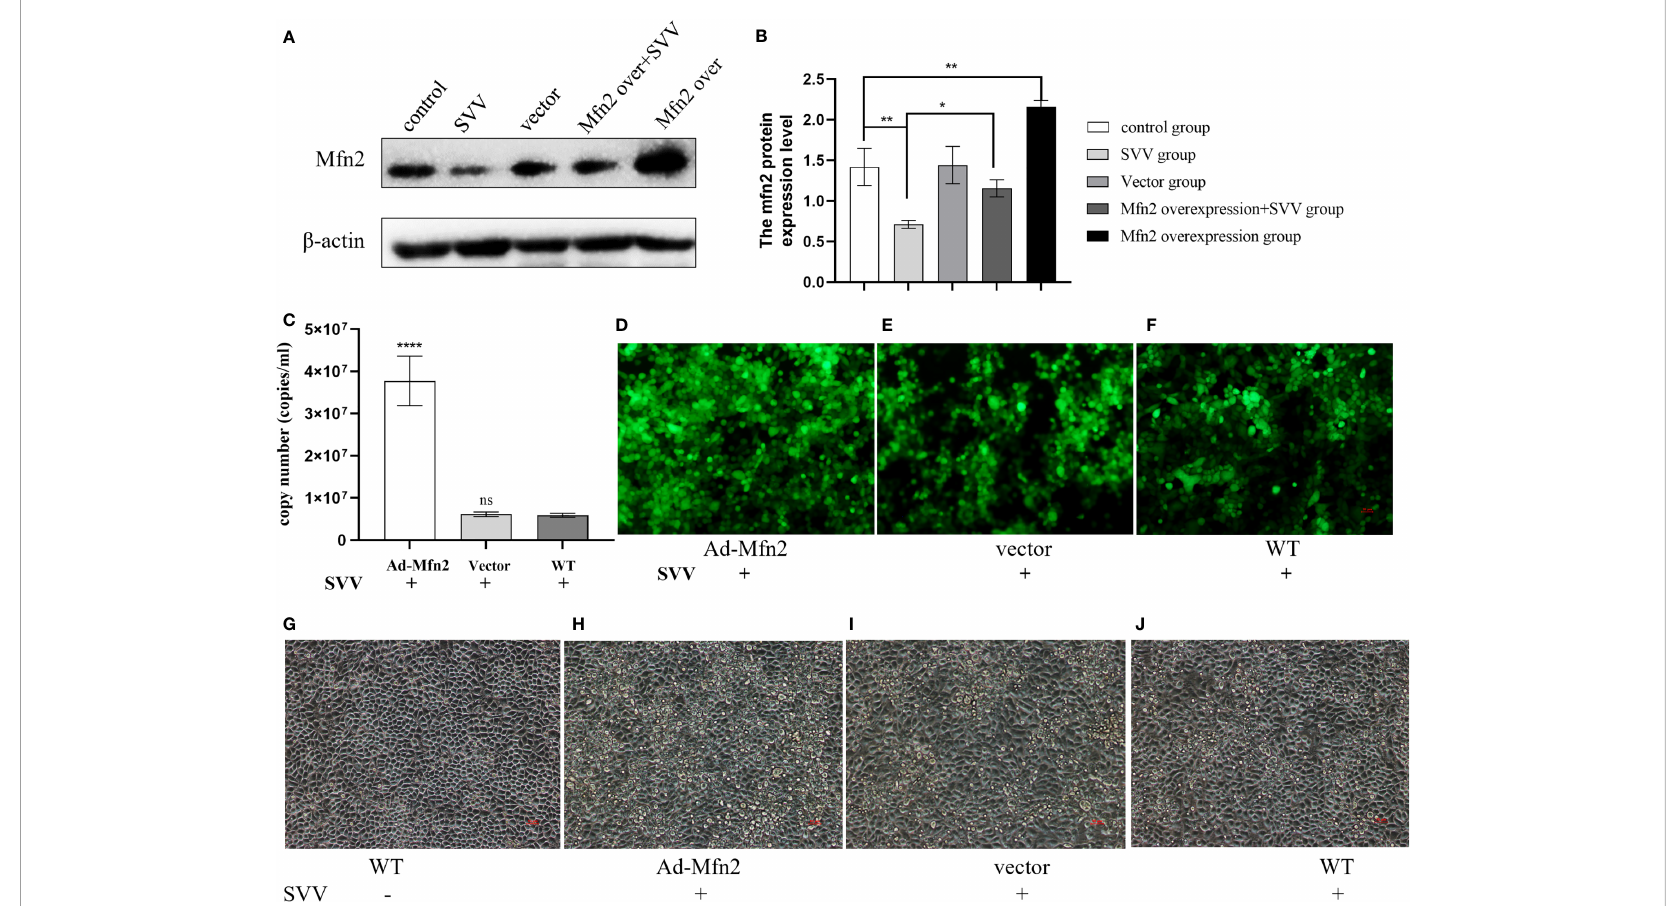
FIGURE 4 Mfn2 overexpression accelerate SVV proliferation and promote cell damage in PK-15 cells (A) The western blot assay for Mfn2. (B) The relative protein expression level of Mfn2. (C) The qRT-PCR assay for SVV copy number. (D – F) The immunocytochemistry assay for SVV detection. (G – J) The change of PK-15 cells morphology after Mfn2 overexpression. One-way analysis of variance (ANOVA) were used to investigate the signi fi cance of differences between the WT and other groups. *; P < 0.05, **; P < 0.01, ****; P < 0.001, ns means no signi fi